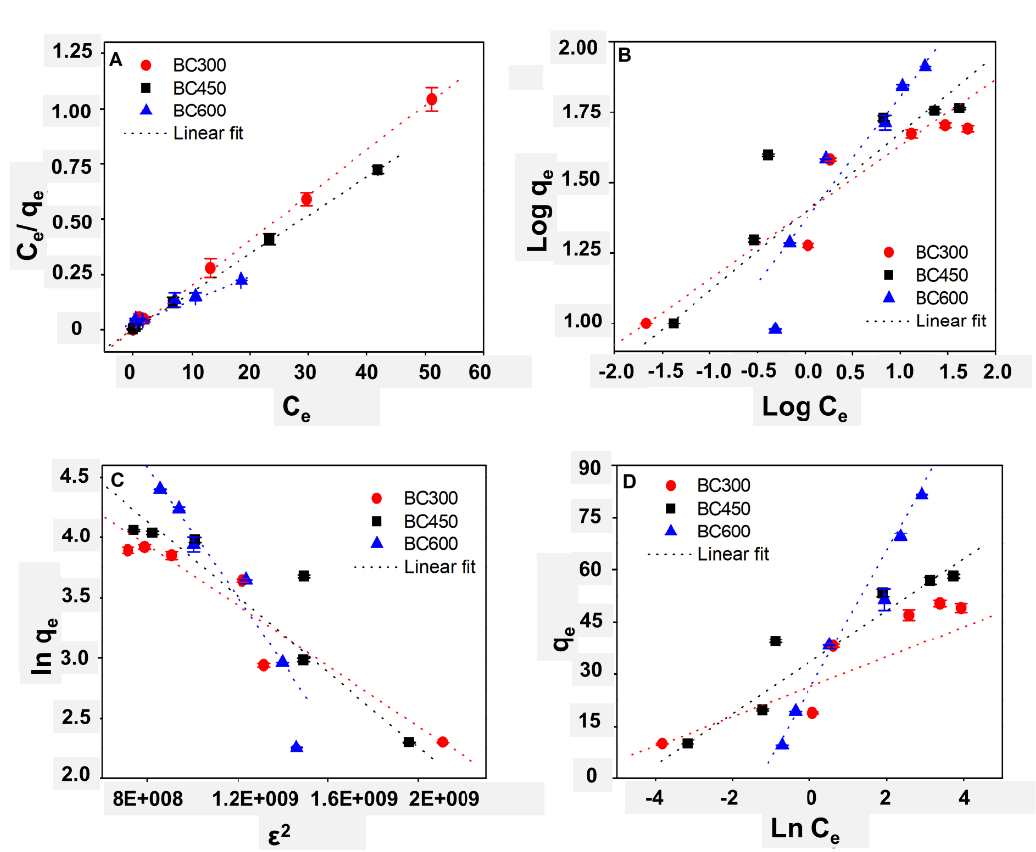
Figure 3. Linear regression of measured adsorption isotherms using ( A ) Langmuir, ( B ) Freundlich, ( C ) Dubinin– Radushkevich, and ( D ) Temkin linearized models for the studied biochar samples (BC300, BC450, and Table 4. Adsorption isotherm parameters of the Langmuir, Freundlich, Dubinin – Radushkevich, and Temkin models determined for the biochar samples from Macrocystis pyrifera under study.